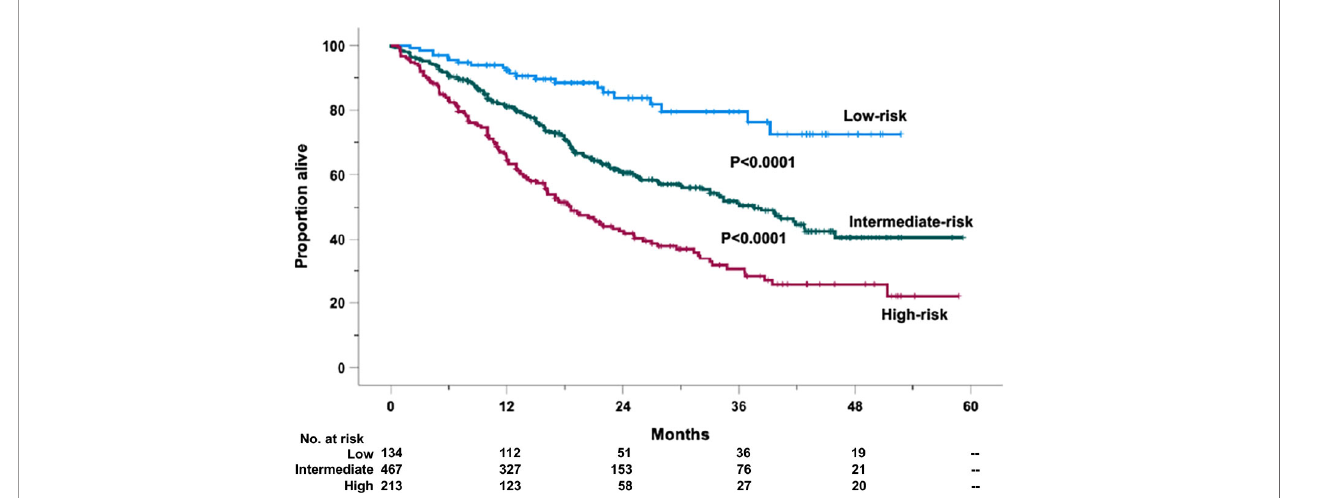
FIGURE 1 | Overall survival (OS) of the retrospective relapsed/refractory (RR) multiple myeloma cases treated with KRd or EloRd clustered in low- (1st quartile, 134 cases), intermediate- (2nd – 3rd quartiles, 467 cases), and high-risk categories (4th quartile, 213 cases), by the fi ve-factor risk model. This analysis was carried out in 814 cases treated with KRd (559 cases) or EloRd (255 cases) in which all the fi ve variables were